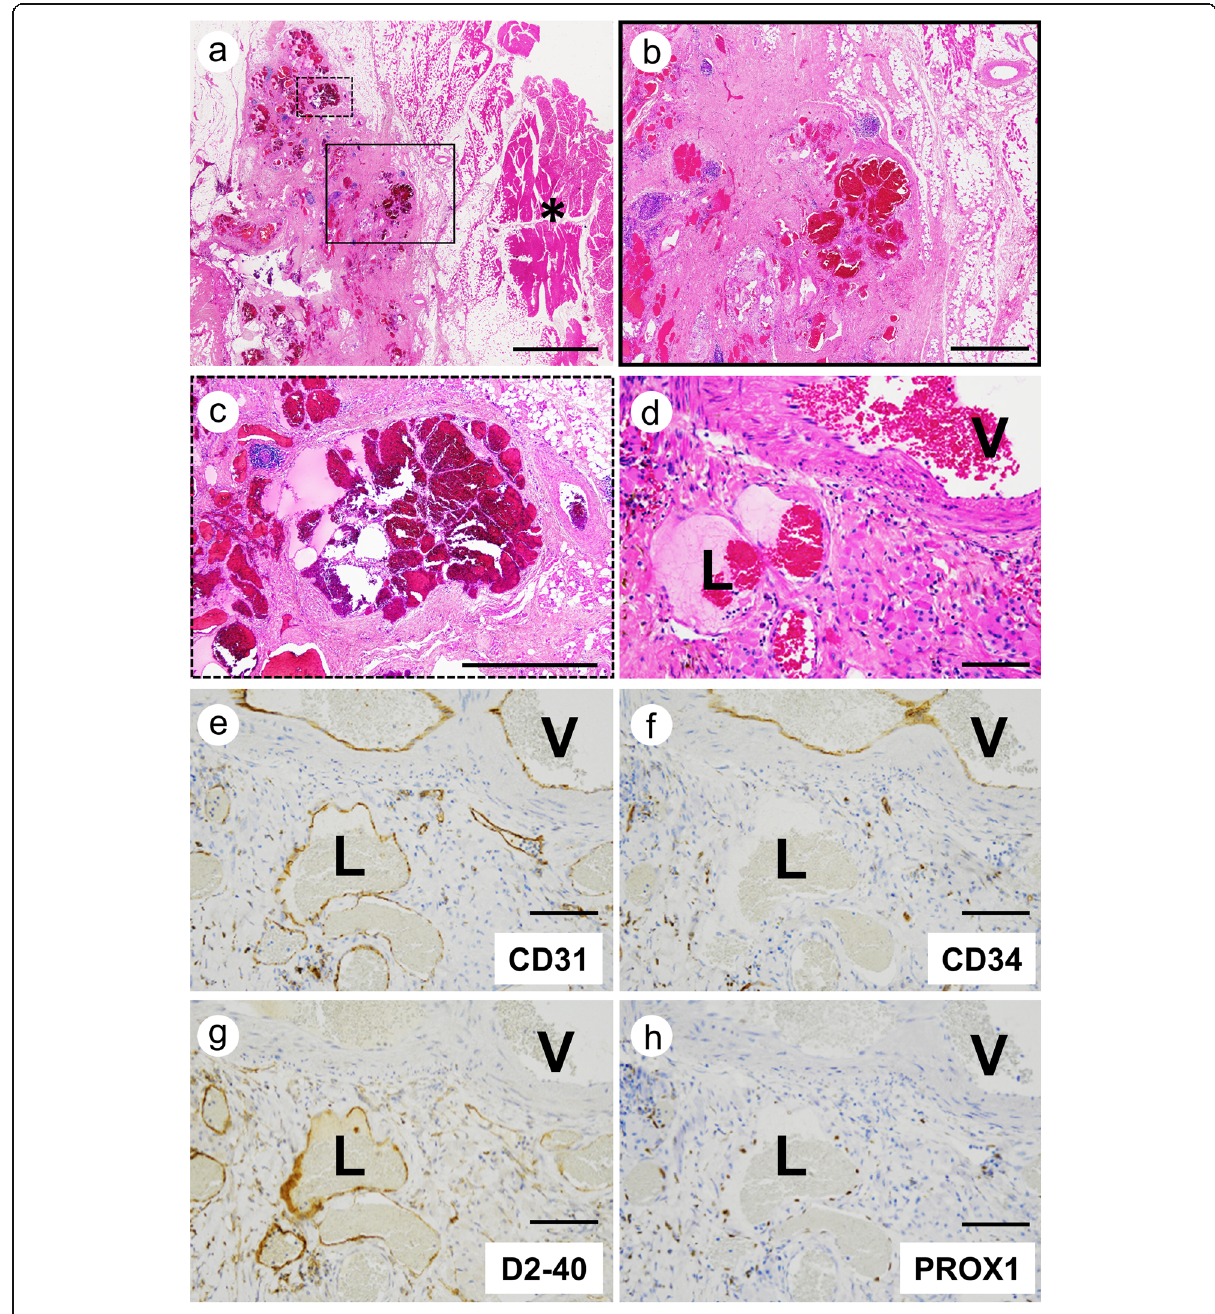
Fig. 2 Histology and immunohistochemical analysis of vascular markers. Representative H&E staining of FAVA ( a ; loupe image, b ; higher magnification of black box in a, c ; higher magnification of dot box in a). Asterisk (*) indicated skeletal muscle surrounding FAVA lesion. Serial sections stained for H&E ( d ), CD31 ( e ), CD34 ( f ), D2 – 40 ( g ) and PROX1 ( h ). Abnormal veins ( V ) were positive for CD31 and CD34. Abnormal lymphatic vessels ( L ) were positive for CD31, D2 – 40 and PROX1. Scale bars: a = 5000 μ m; b, c = 1000 μ m; d-h = 100 μ